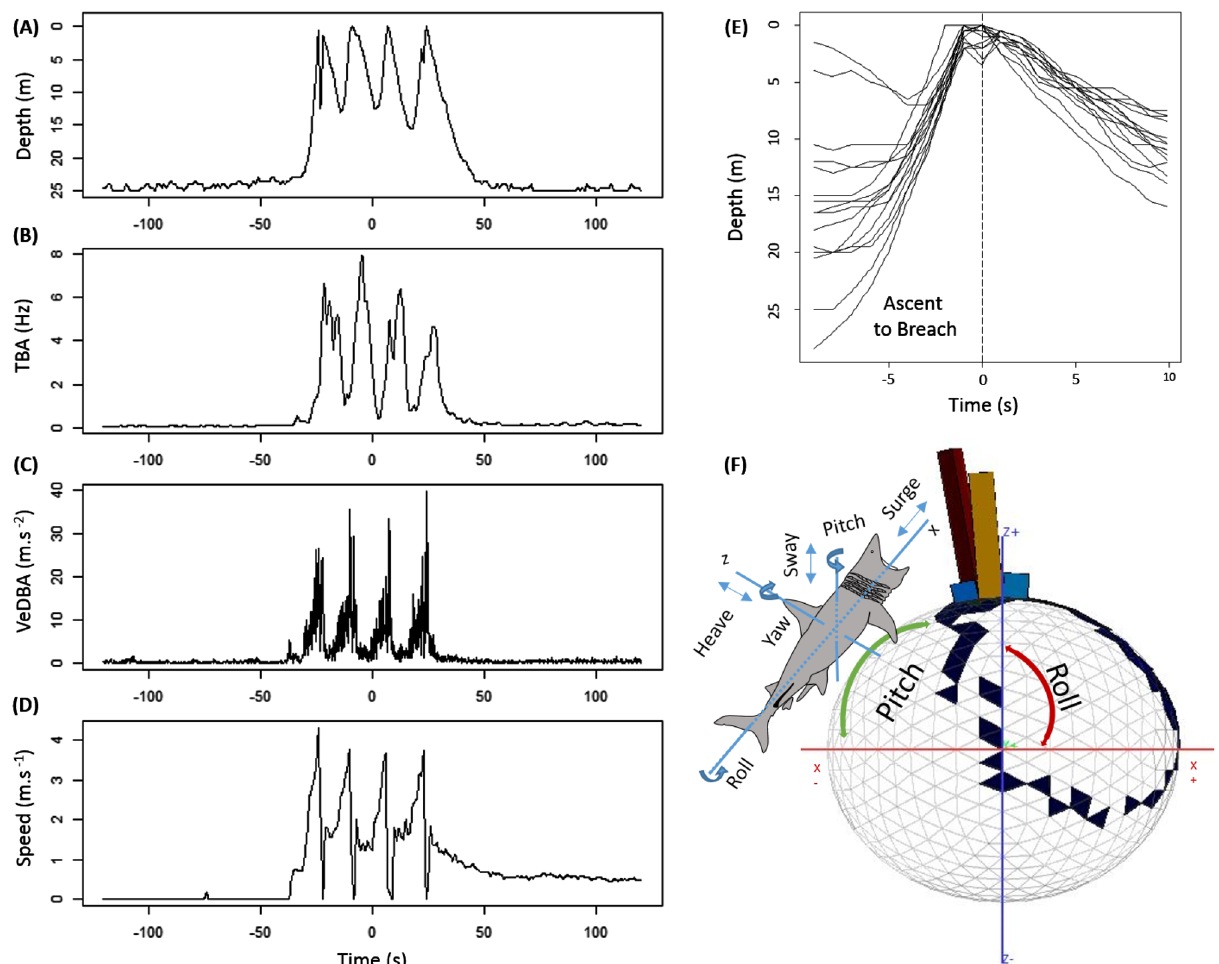
Figure 2. Characteristics of breaching. ( A – D ) A quadruple breach by a six-metre basking shark over 47 s showing changes in depth ( A ), tail beat amplitude ( B ), VeDBA ( C ) and speed ( D ) over the series of breaches. ( E ) Depth profiles of 16 single breaching events performed by a single shark, with time (in seconds) centred on the breach, overlaid on a common timescale showing repeatability of ascent angle and subsequent descent after breaching. ( F ) Dubai plot showing tri-axial acceleration data as a 3-dimensional histogram, with time spent by sharks in a particular posture on each facet of the sphere extruded as triangular bars, and colour scaling with the cumulative time in a given facet. Data show a right-handed breach of a single shark, where rapid rolling is indicated by short dark blue bars on the right face of the